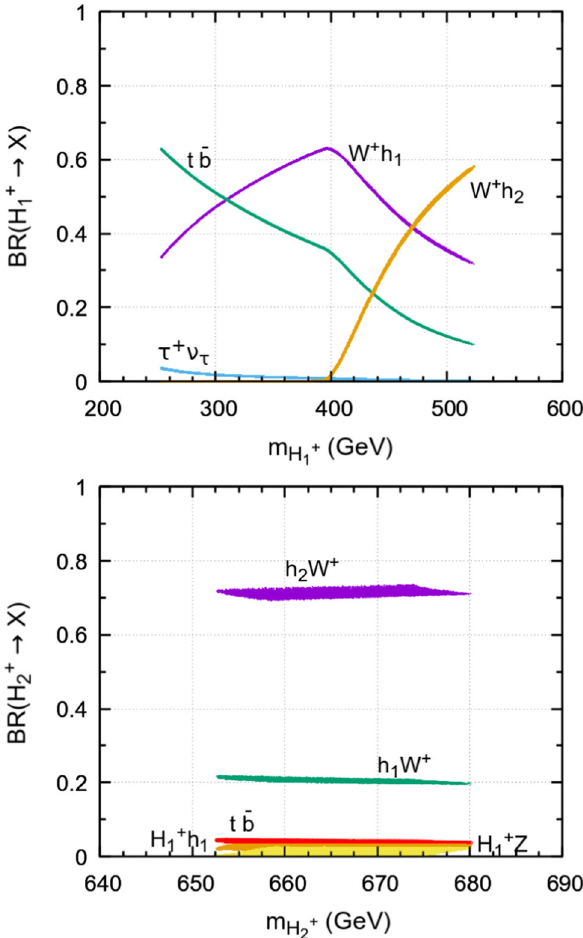
Fig. 12 Dominant BR’s for H + for benchmark point P 3 versus the charged Higgs masses